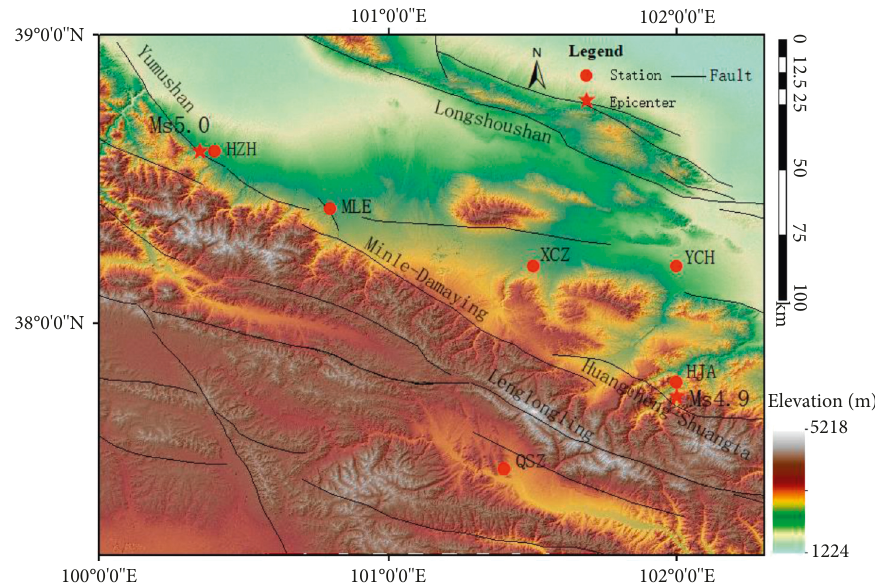
Figure 1: Study area and location of epicentral and strong motion